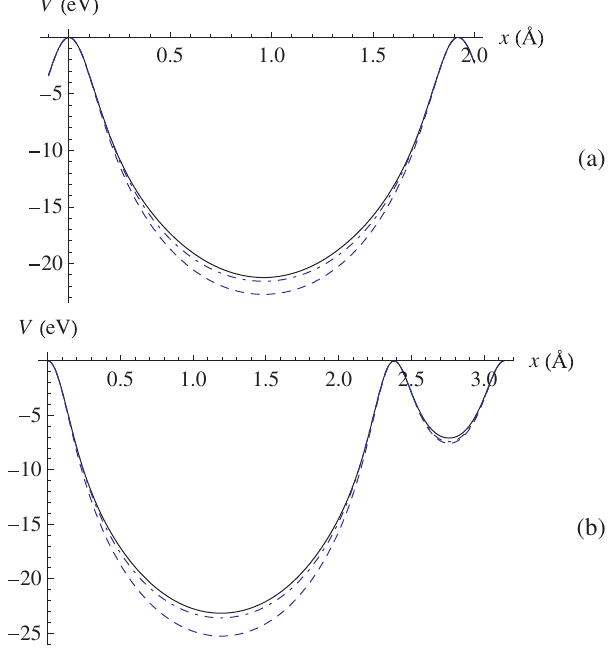
FIG. 5. Planar continuous potentials over one period for positively charged particles in a silicon crystal at room temper- ature, evaluated via Eqs. (74) – (79): (a) in orientation (110); (b) in orientation (111). Black solid curves, HF calculations [by any of Eqs. (86), (87) or (90)]. Blue dashed curves, Moli`ere potential, Eqs. (80) and (81). Blue dot-dashed, Moli`ere potential with modified screening radius